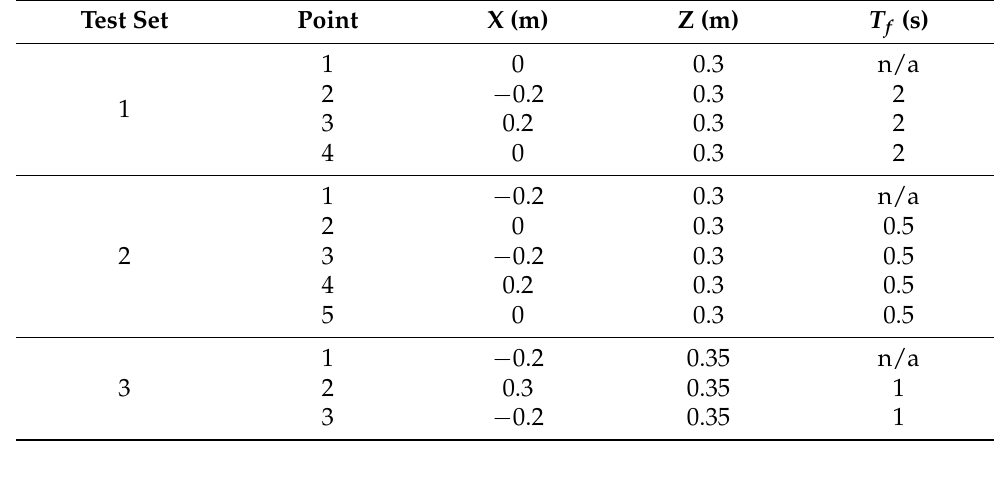
Table 4. Set of x , z positions.